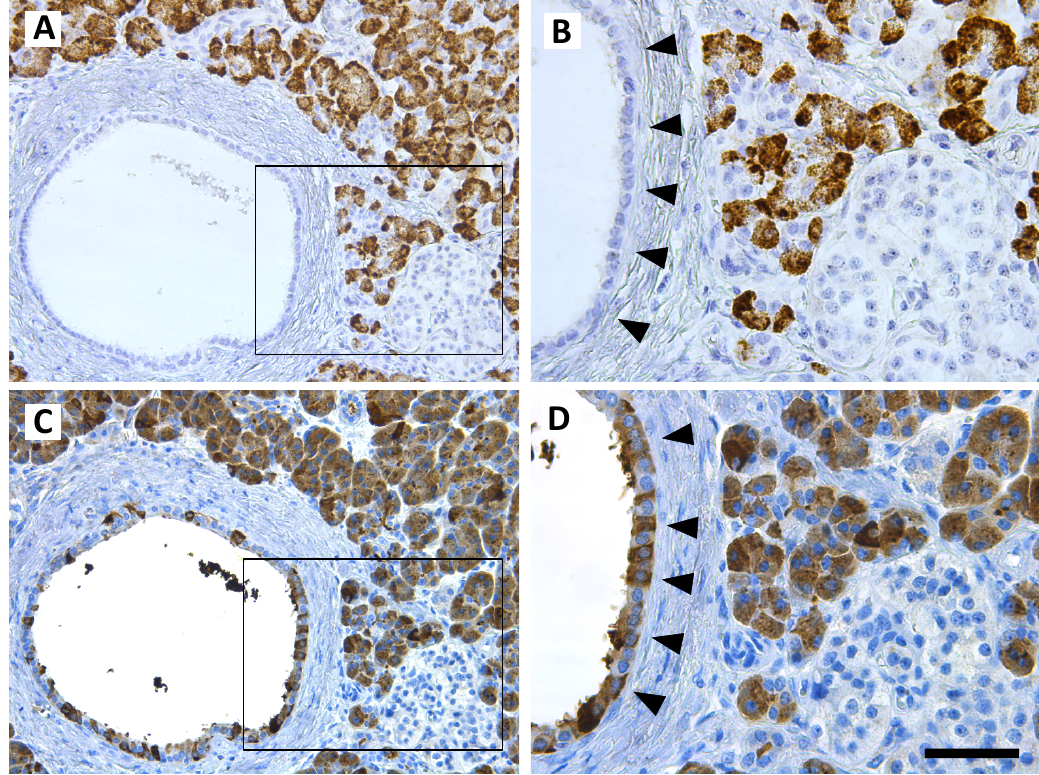
Figure 4. Evidence for in vivo reuptake of secreted CEL protein in human pancreatic ductal cells. Low ( A ) and high ( B ) magnification of in situ hybridization staining in morphologically preserved pancreatic tissue from a case of pancreatic ductal adenocarcinoma. The acinar cells were strongly positive for CEL mRNA transcripts, whereas ductal (arrowheads) and islet cells (lower right corner) were negative. Low ( C ) and high ( D ) magnification of an adjacent tissue section that was immunostained for CEL protein expression with an anti-CEL antibody (Sigma-Aldrich). Acinar cells were positive and islet cells negative as in ( A , B ). Positive, patchy staining of varying intensity in ductal cells (arrowheads) indicated that CEL protein might have been endocytosed from the pancreatic juice by these cells. Scale bar is 100 µ m for low magnification ( A , C ) and 50 µ m for high magnification ( B , D